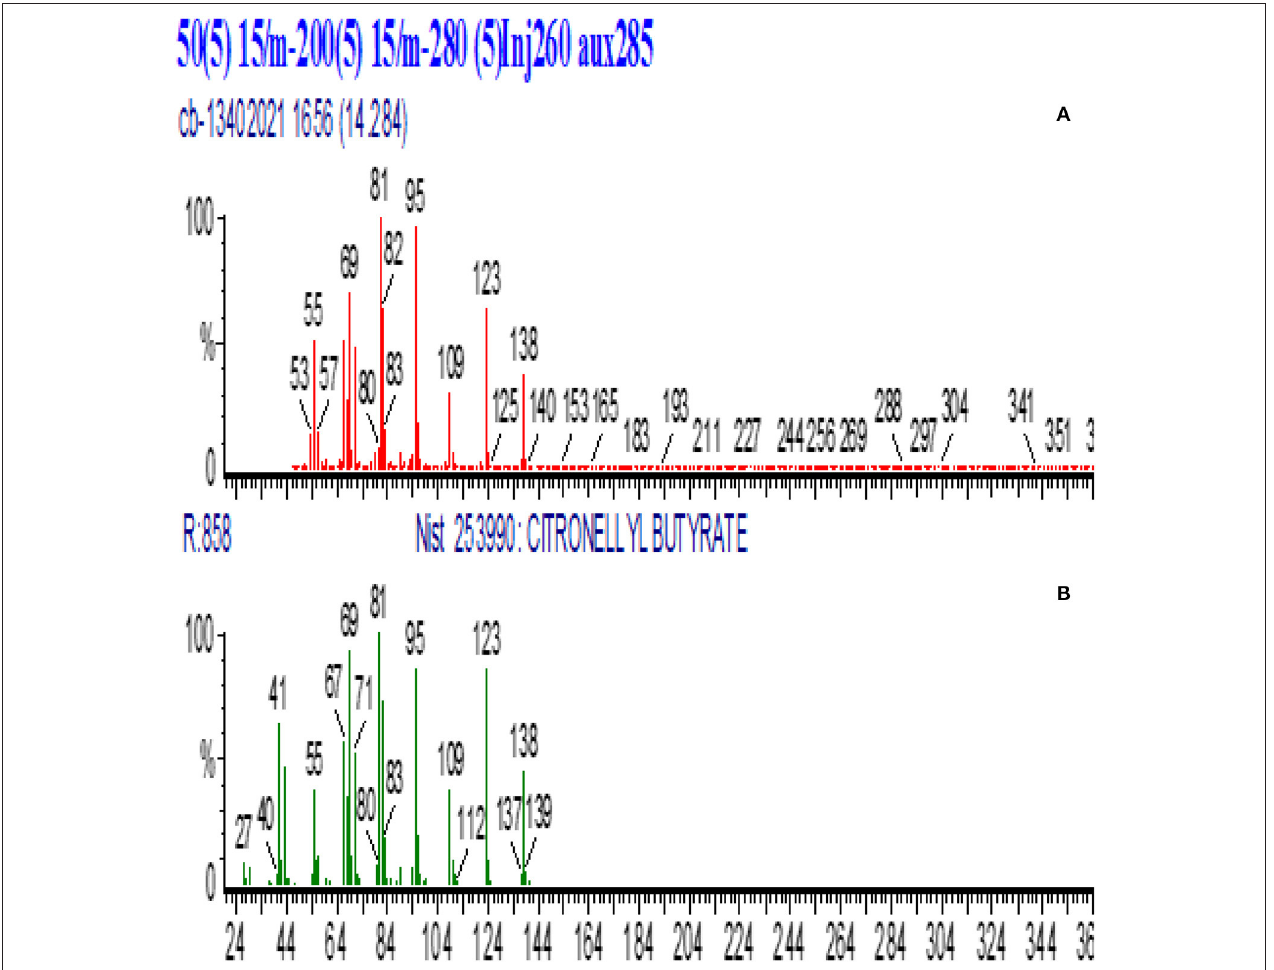
FIGURE 6 | GC-MS spectra of partially purified citronellyl butyrate peak (2Z) and its conformation in this study. (A) Synthesized citronellyl butyrate, (B) GC-MS Library of citronellyl